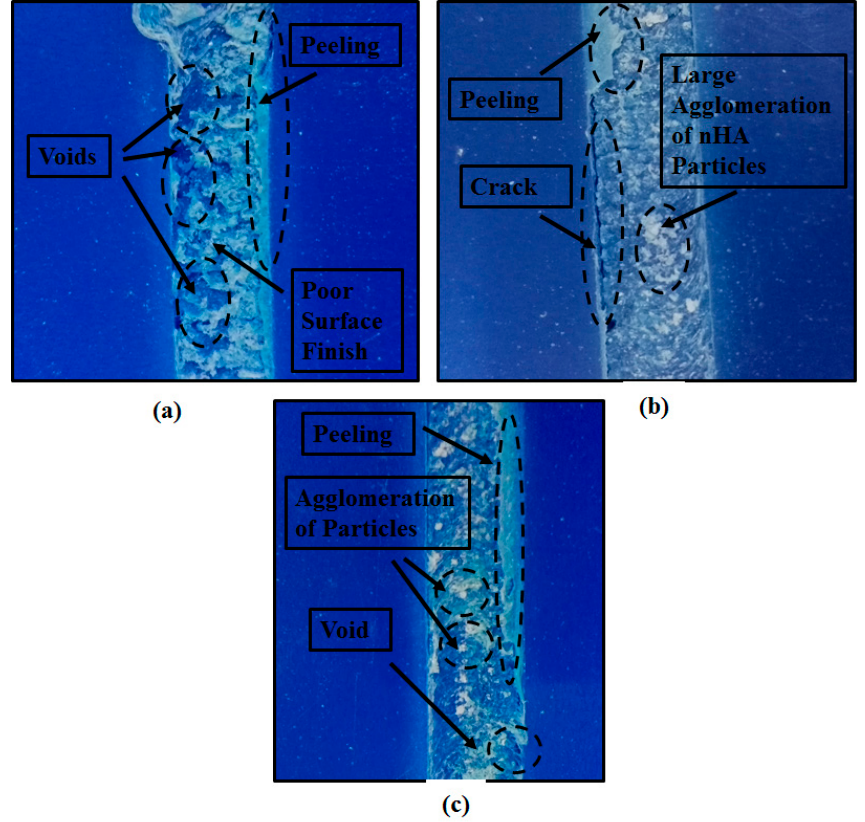
Figure 4. Defects observed in various experiments: ( a ) experiment at low T and low ω , ( b ) experiment at low ω , high v , and high f and ( c ) experiment at high v and high f .